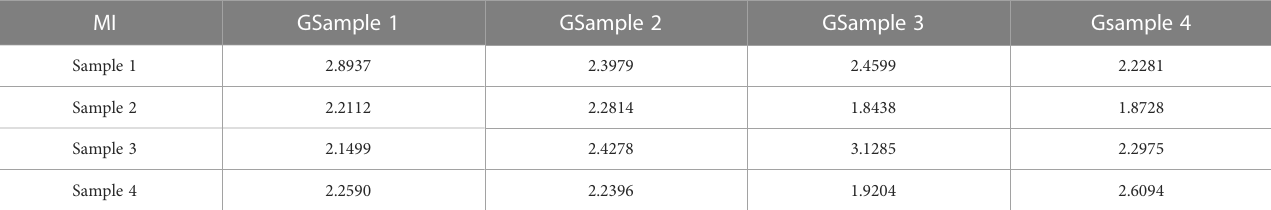
TABLE 2 Mutual information results.